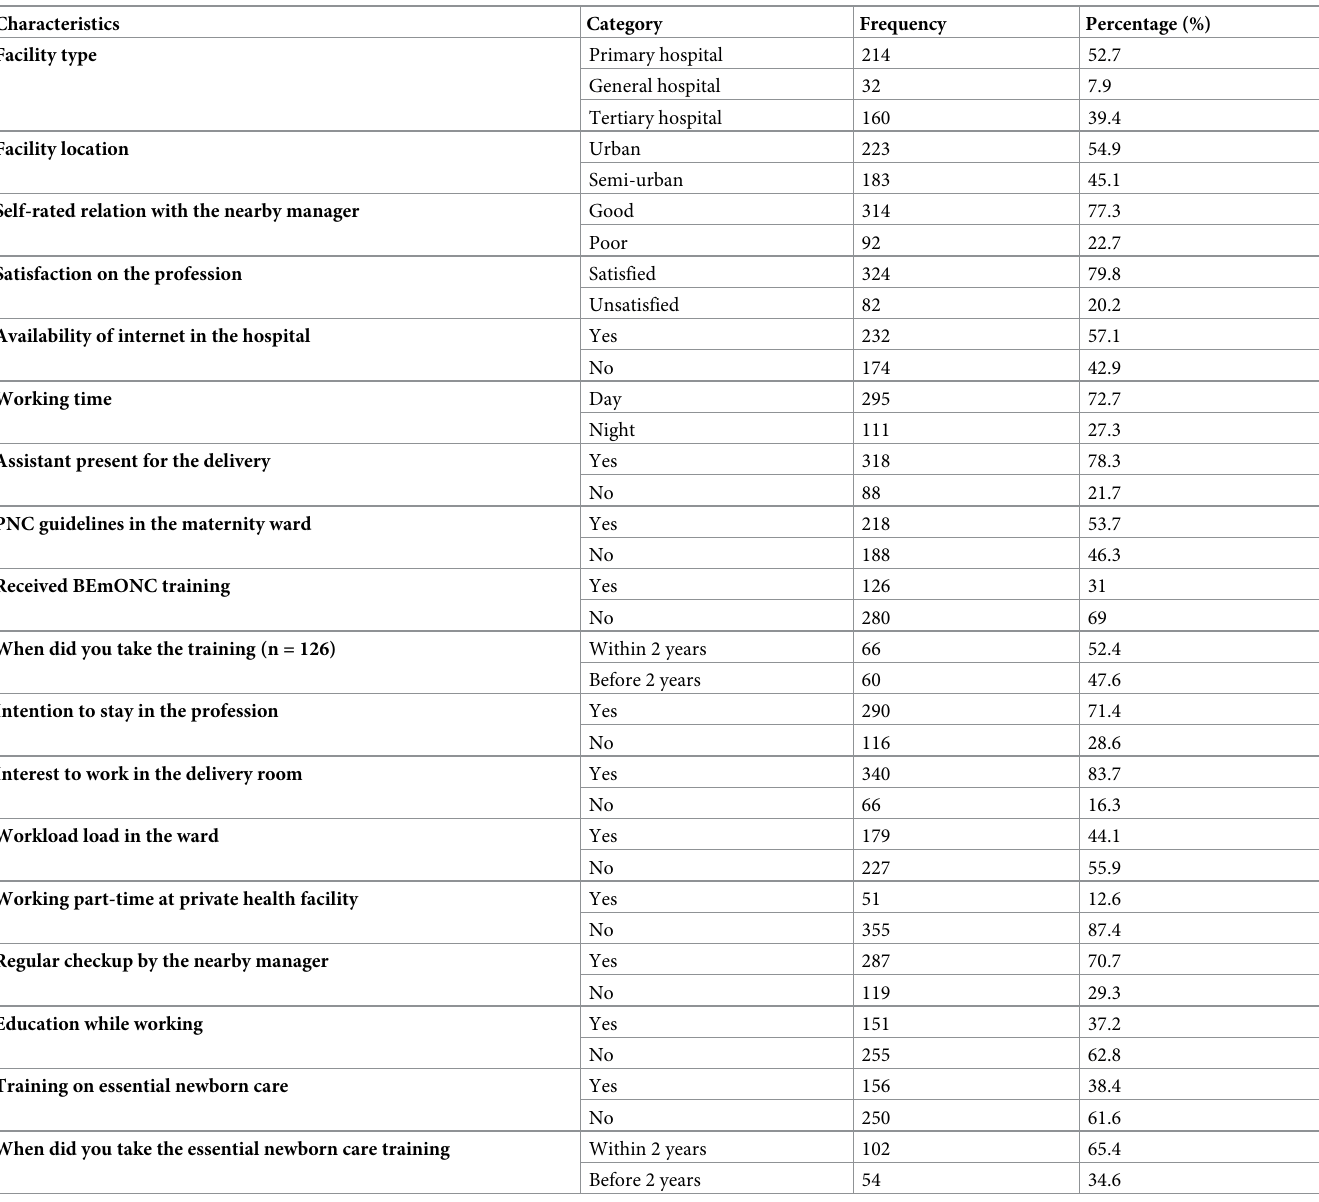
Table 2. Workplace and professional related characteristics of study participants in Gondar province hospitals, northwest Ethiopia, 2020/2021 (n = 406).